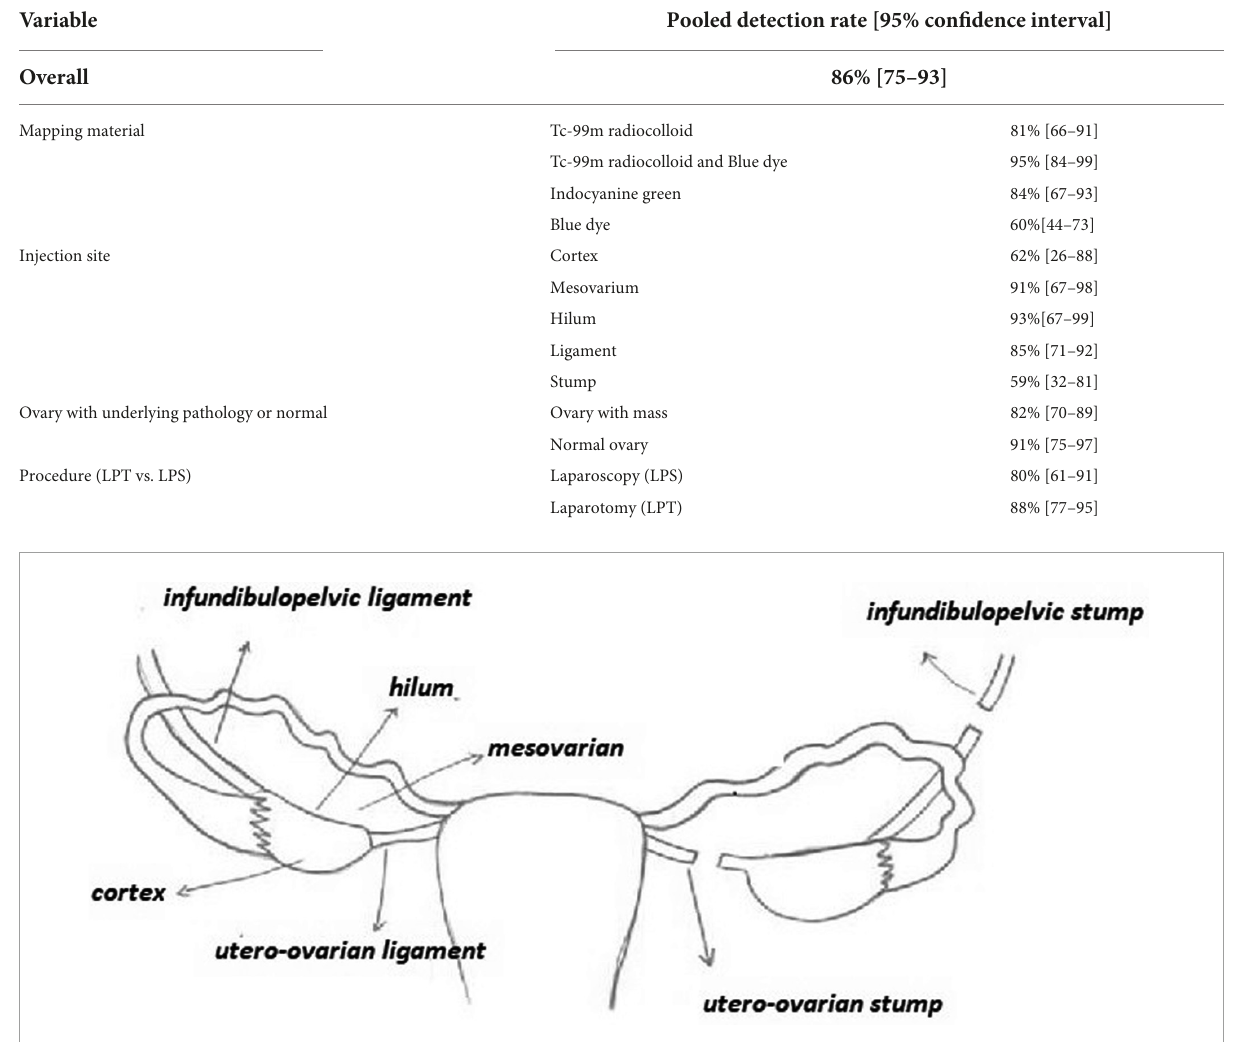
TABLE 2 Pooled detection rate based on different variables.